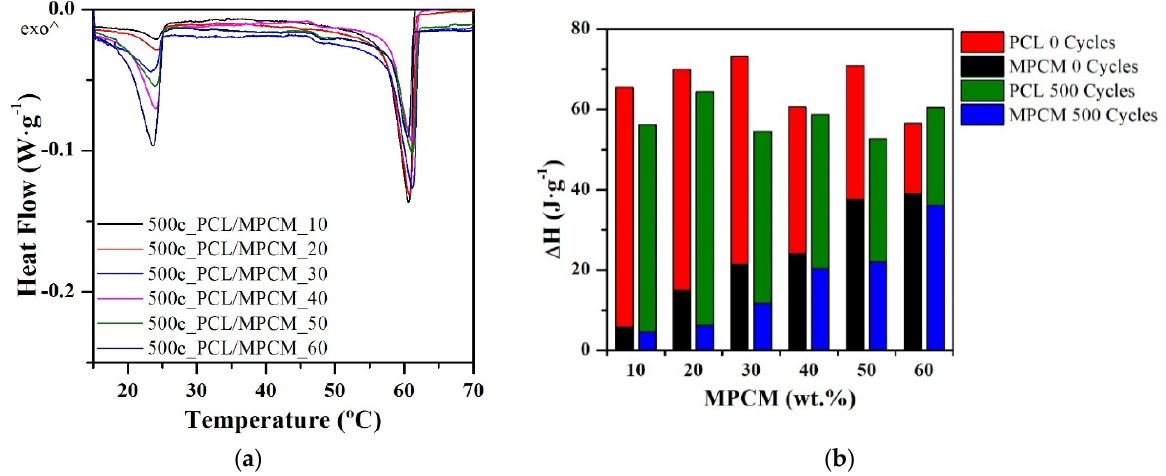
Figure 10. ( a ) Heat flow curves after the thermal cycling of MPCM CSS-PCM; ( b ) Enthalpy and melting temperature results before and after thermal cycling of MPCM CSS-PCM.